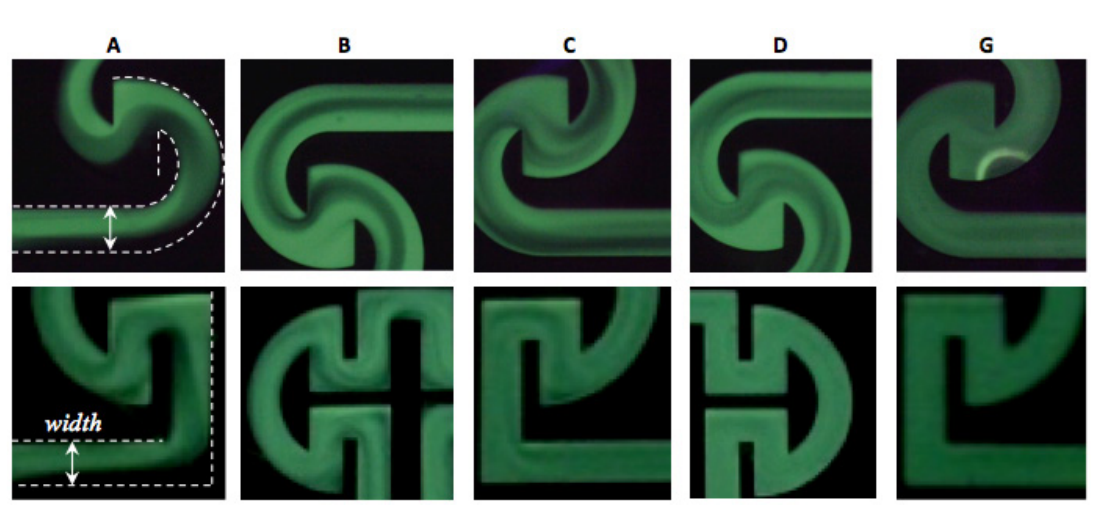
Figure 10. Diffusion process along micromixer channel length of FITC and water at Re = 50. Semi-circle shape (2nd row) and Ω (3 rd row).